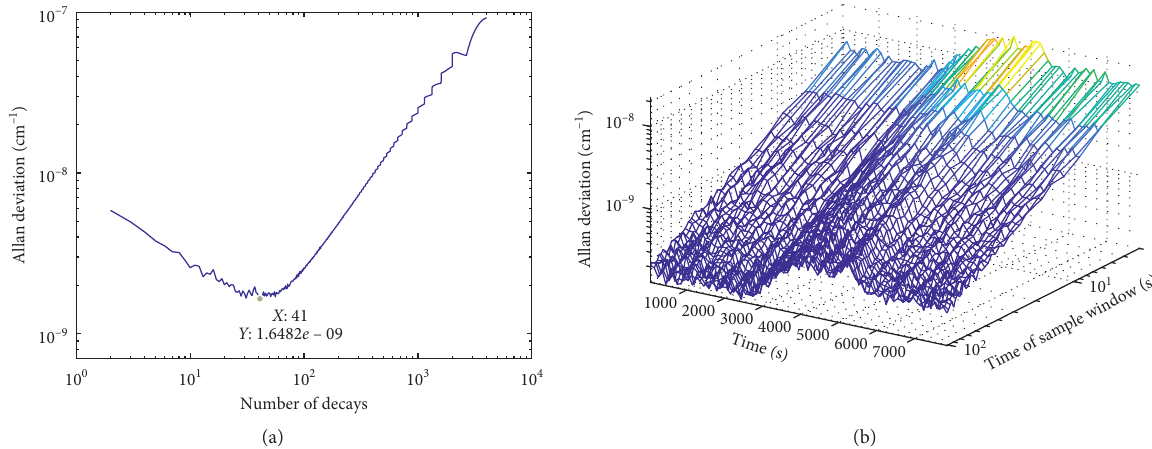
Figure 7: Comparative analysis of Allan variance and DAVAR. (a) The relationship between ring-down time and temperature change in Allan variance analysis. (b) The relationship between ring-down time and temperature change in DAVAR. Figure 4. The steps for differential detection are as